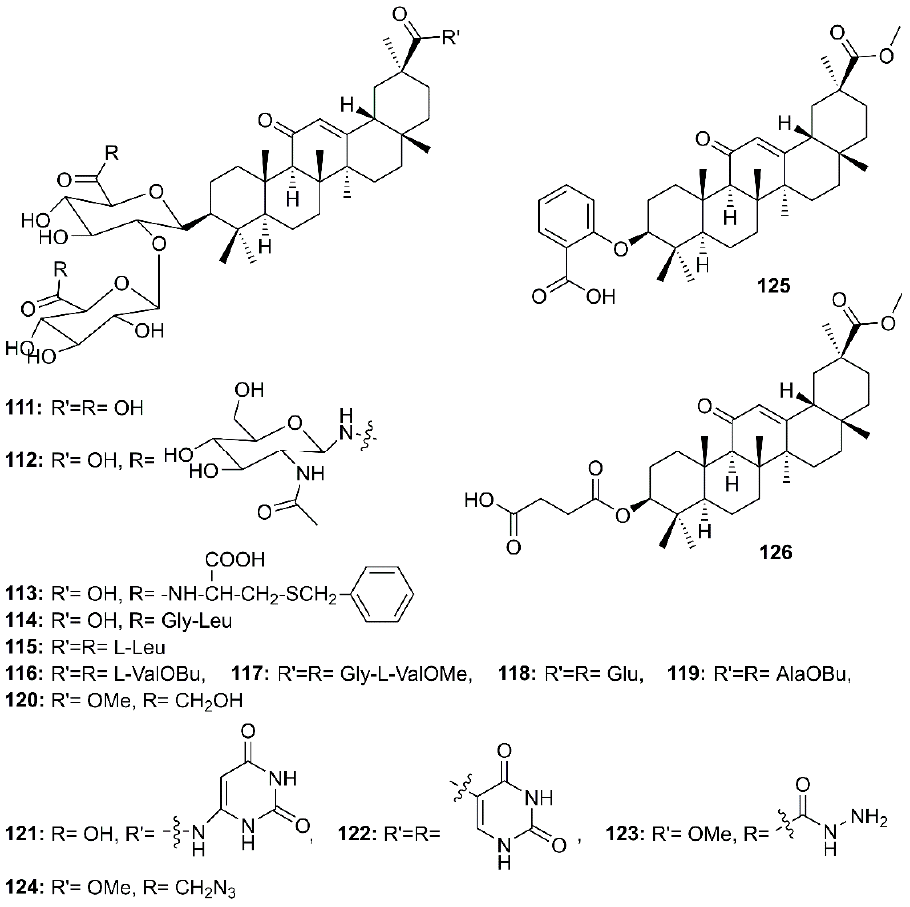
Figure 18. Structures of glycyrrhizin ( 111 ) and its synthetic analogs 112–126 .